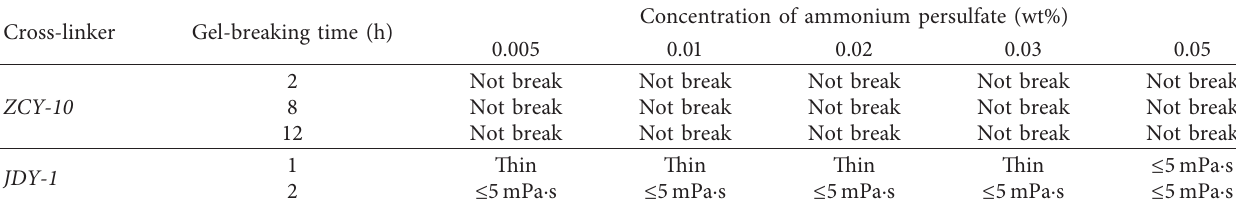
Table 6: Gel-breaker profile of the weighted fracturing fluid at 120 ° C. Cross-linker